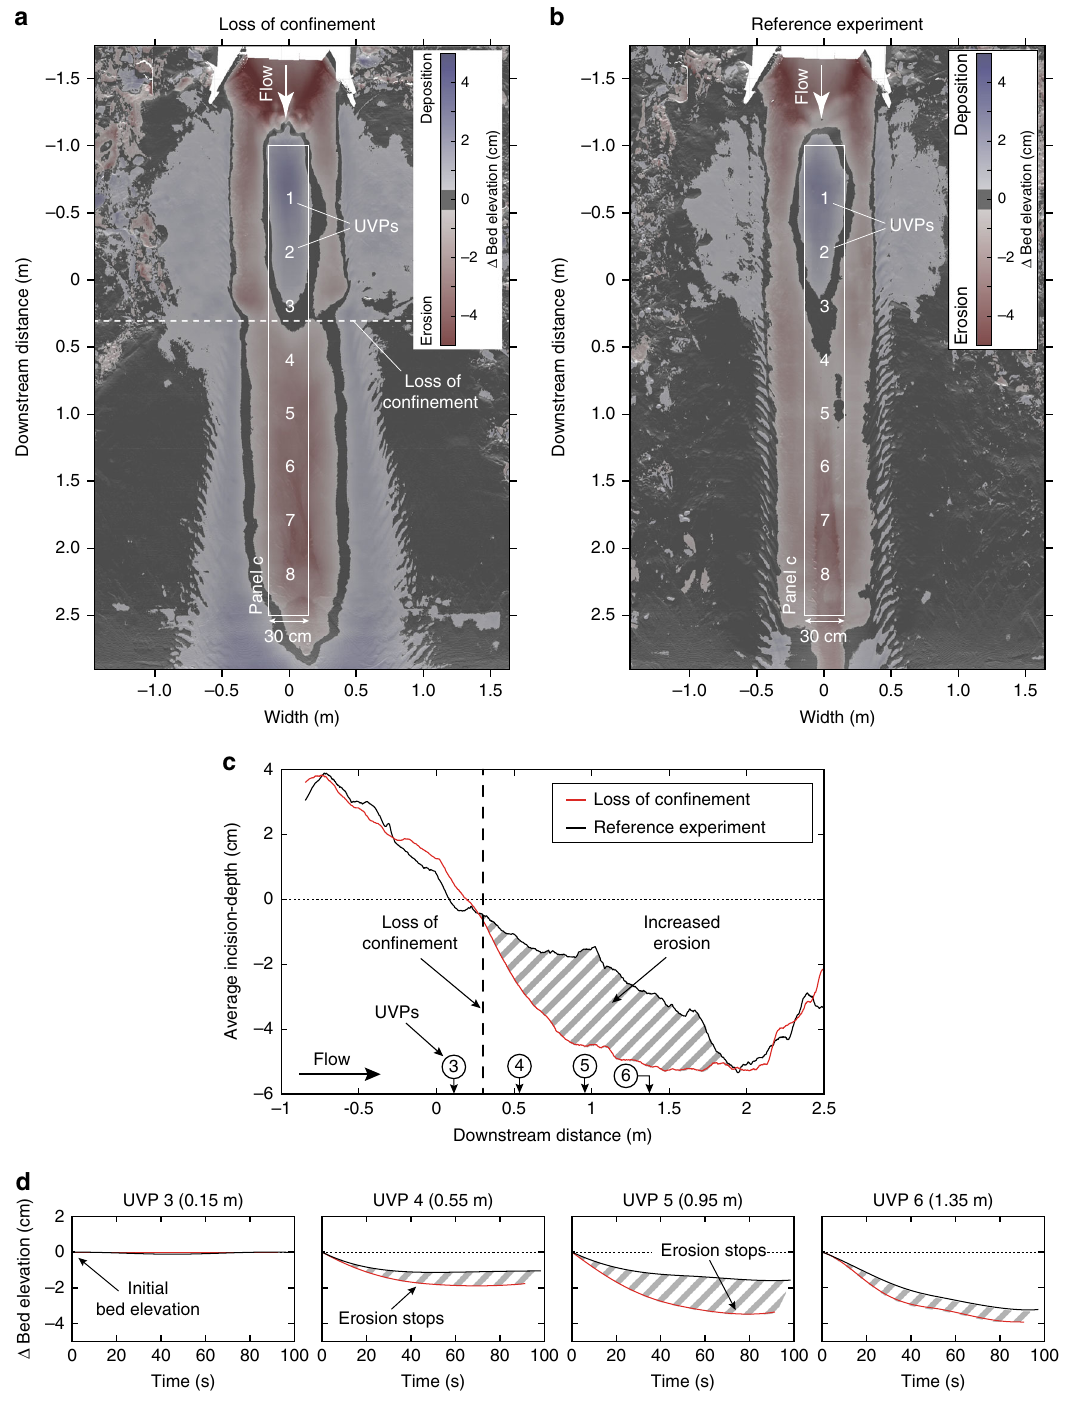
Fig. 3 Erosion and deposition in the two experiments. a Map showing erosion and deposition in the experiment with the loss of con fi nement. b Erosion and deposition in the reference experiment. c Laterally averaged incision-depth of a 30 cm wide strip along the channel thalweg. Erosion in the experiment increased with the loss of con fi nement. d Bed-elevation change during the experiments as captured in the footprint of the Ultrasonic Velocimetry Probes (UVP) (see Methods). Bed-elevation change was generally higher in the experiment with the loss of con fi nement than in the reference experiment. The difference was highest below UVP 5, which was located 0.95 m downstream of the loss of con fi